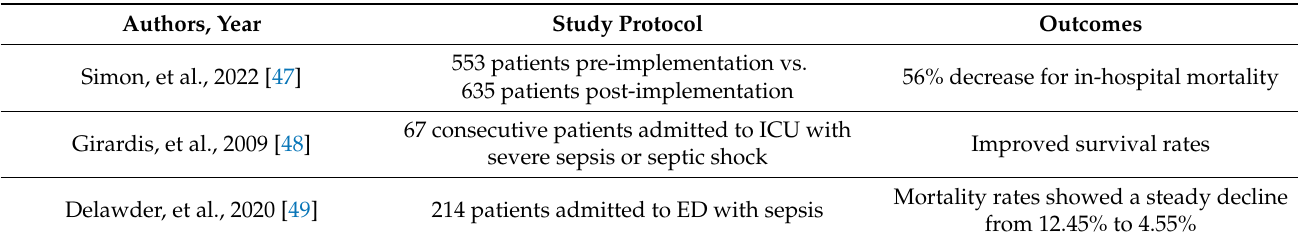
Table 3. Major studies investigating outcomes of implementation of sepsis